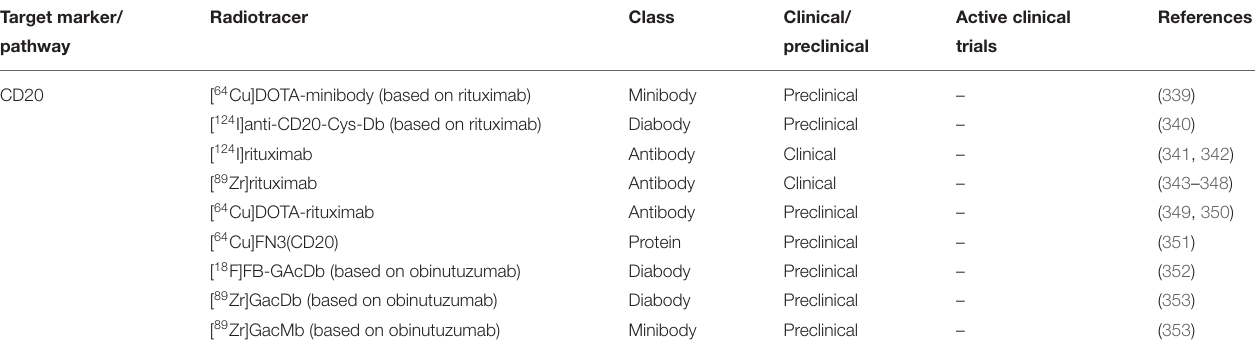
TABLE 3 | B cell targeted PET radiotracers.